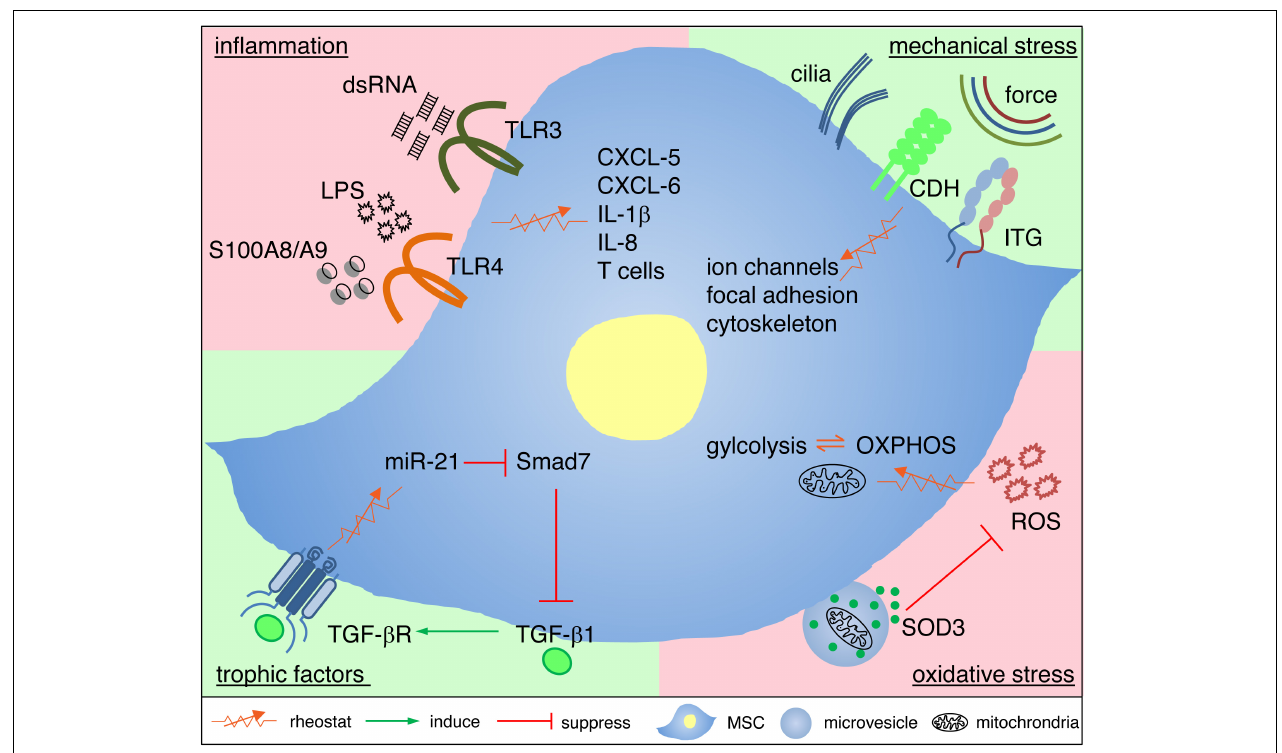
FIGURE 2 | Cellular and molecular mechanisms underlying adaptive responses of MSCs. MSCs utilize rheostatic (sensing) mechanisms to respond to the local environment in granulation tissue with deficient or excessive trophic factors, inflammatory mediators, oxidative stress or mechanical stress. This adaptive response to cues from the microenvironment depends on distinct intracellular signaling, changes of the transcriptome and metabolic reprogramming. Adaptive MSC responses, in consequence, rebalance the partly hostile microenvironment, and thus protect themselves by rebalancing their niche, and this favors a shift to healing and tissue homeostasis. For further details see main text. CDH, cadherins; ITG, integrins; OXPHOS, oxidative phosphorylation, ROS, reactive oxygen